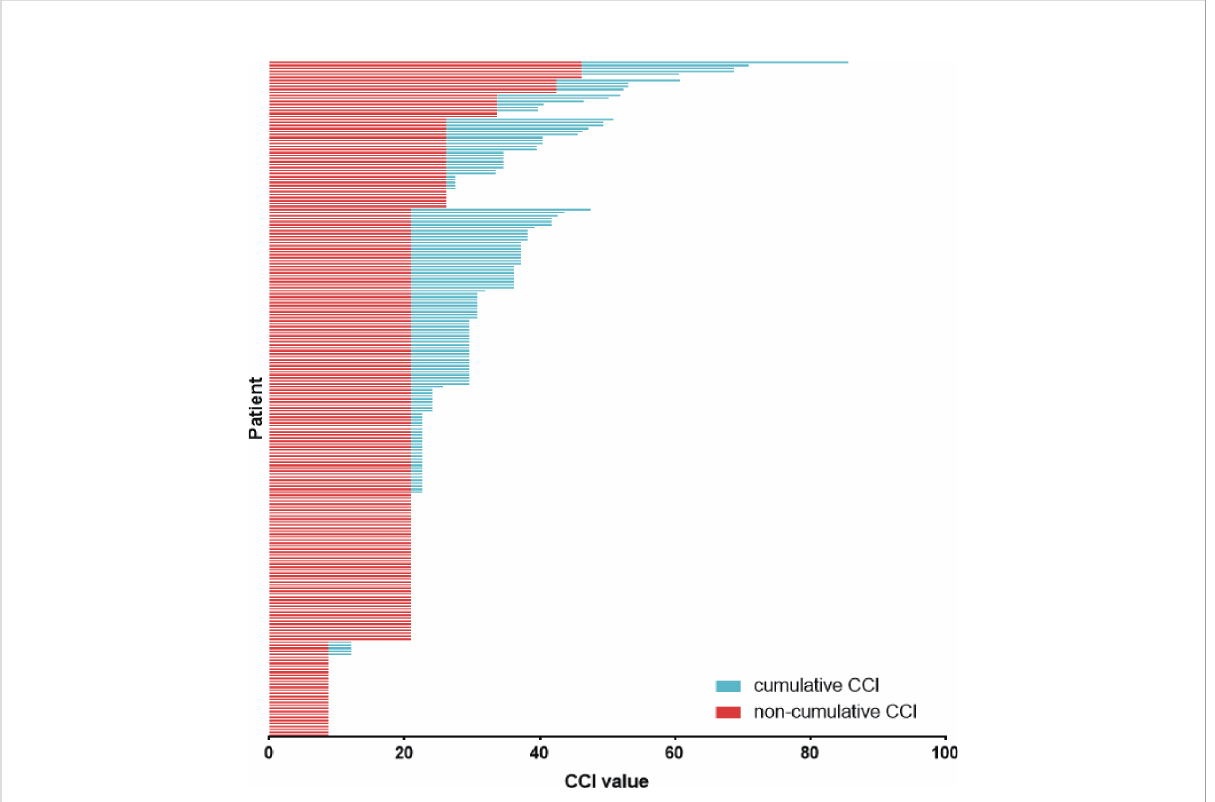
FIGURE 1 Non-cumulative CCI and cumulative CCI of patients with complications. CCI = Comprehensive Complication